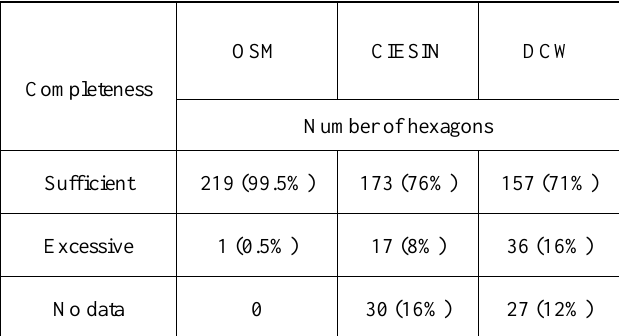
Table 3. Number of hexagons per completeness classes